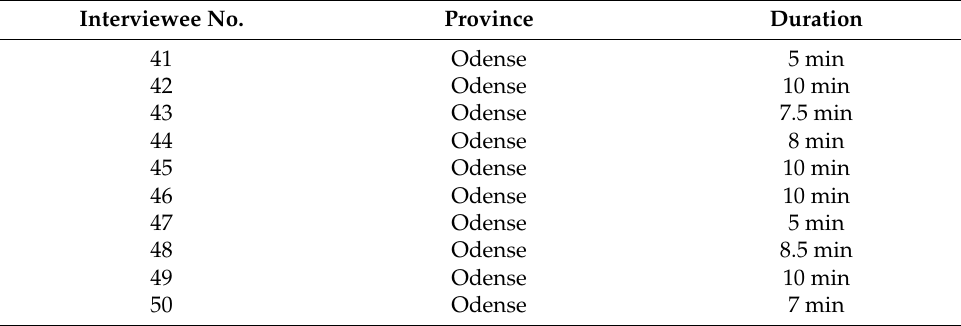
Table A5. Interviews and Interviewees of Danish Participants: Segment 2. Interviewee No.